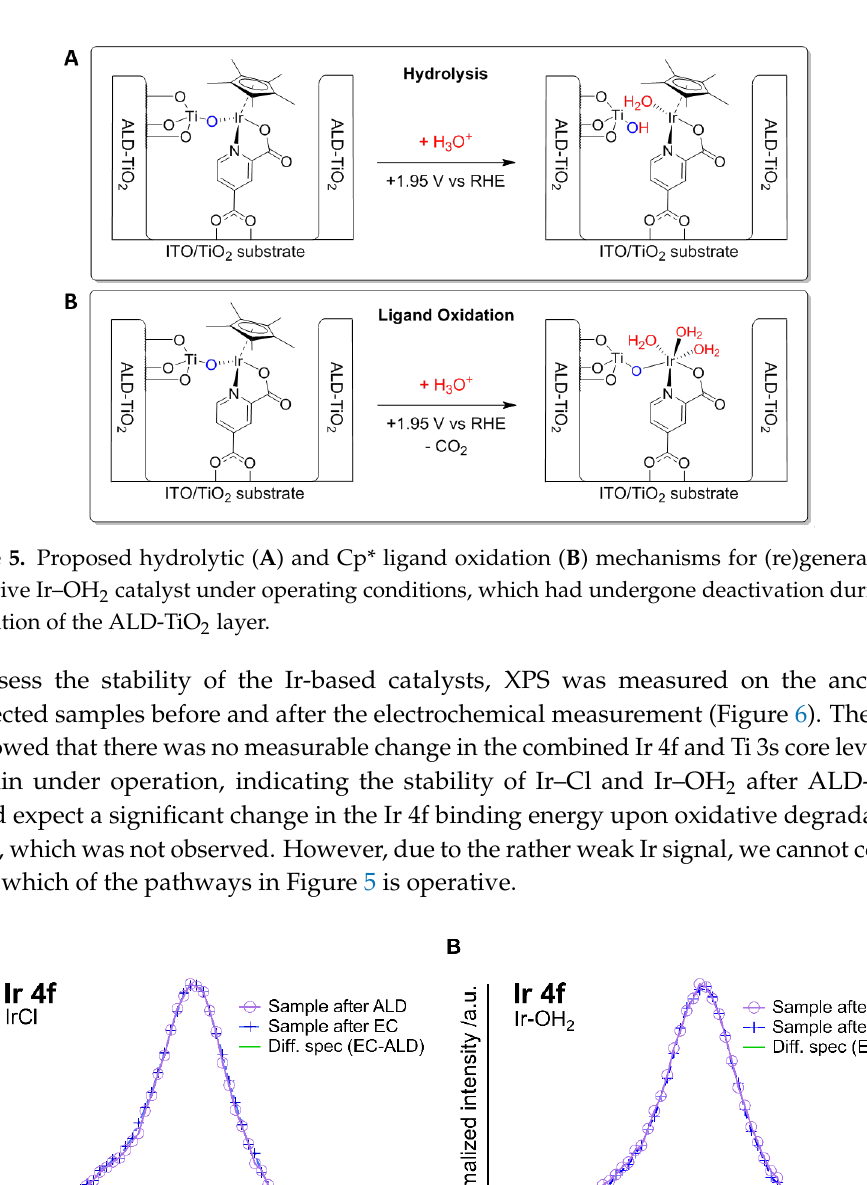
Figure 6. XPS spectra of ( A ) Ir–Cl and ( B ) Ir–OH 2 with ALD-TiO 2 before and after electrochemical measurements. The respective difference spectra are shown in green.